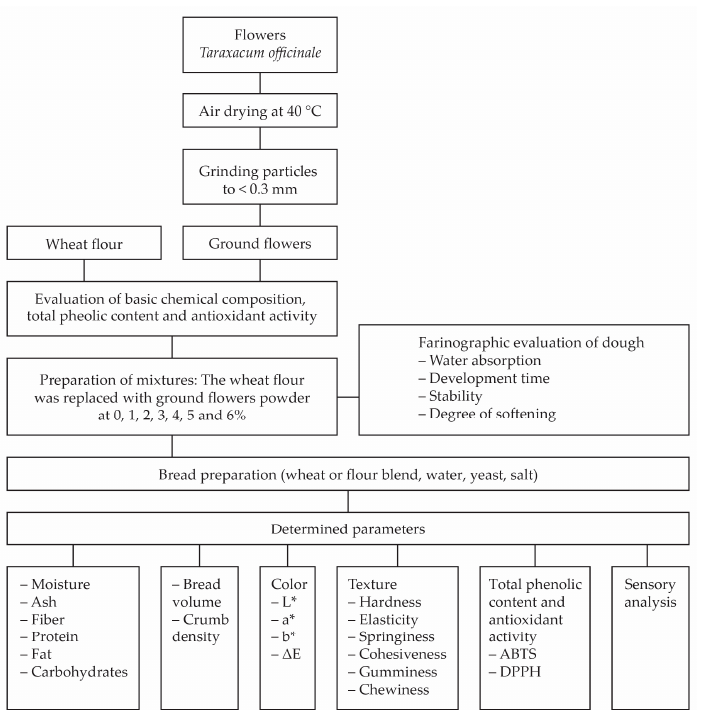
Figure 1. Graphical scheme of conducted studies. L*, a*, b* and ∆ E—lightness, redness, yellowness and total color difference, respectively; ABTS and DPPH—antiradical activities.